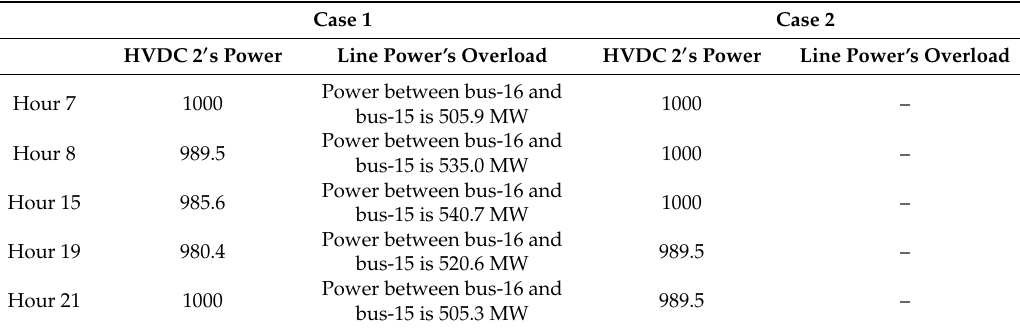
Table 3. HVDC 2 transmission power and AC transmission power HVDC1 block